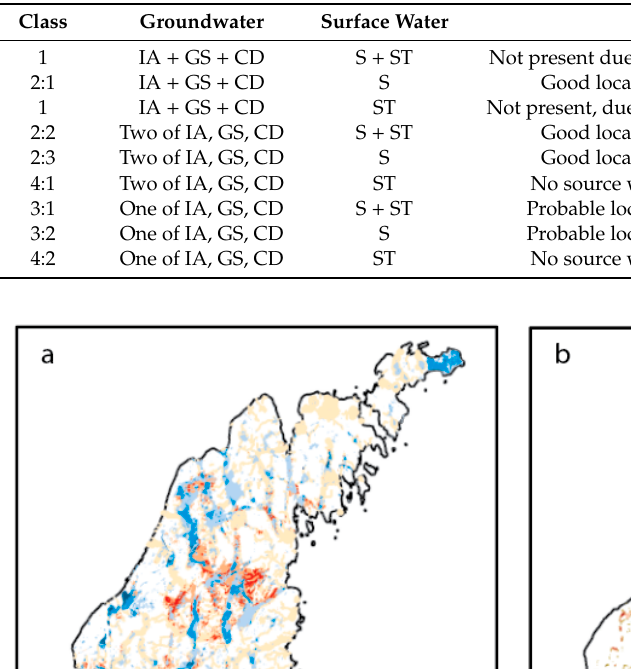
Table 1. Synthesis from final step in GIS analyses. GS = Ratio > 1.0 groundwater recharge / storage capacity; CD = Closed depression; IA = sand / gravel > 4m; S = Raw water Source; ST = Storage. Location of mapped classes see Figure 3b.